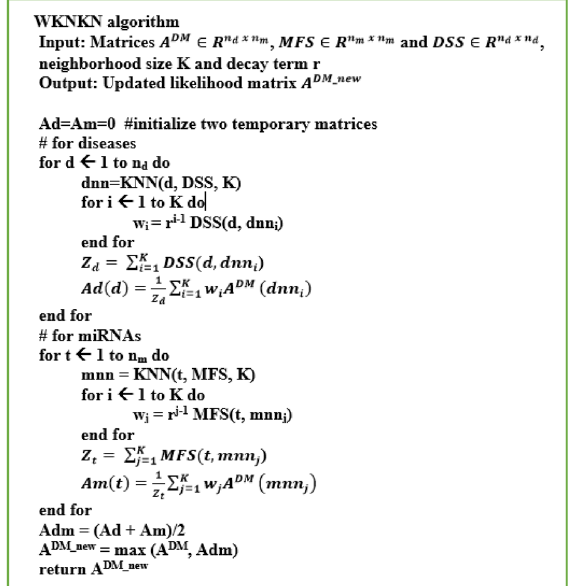
Figure 3. The WKNKN algorithm.